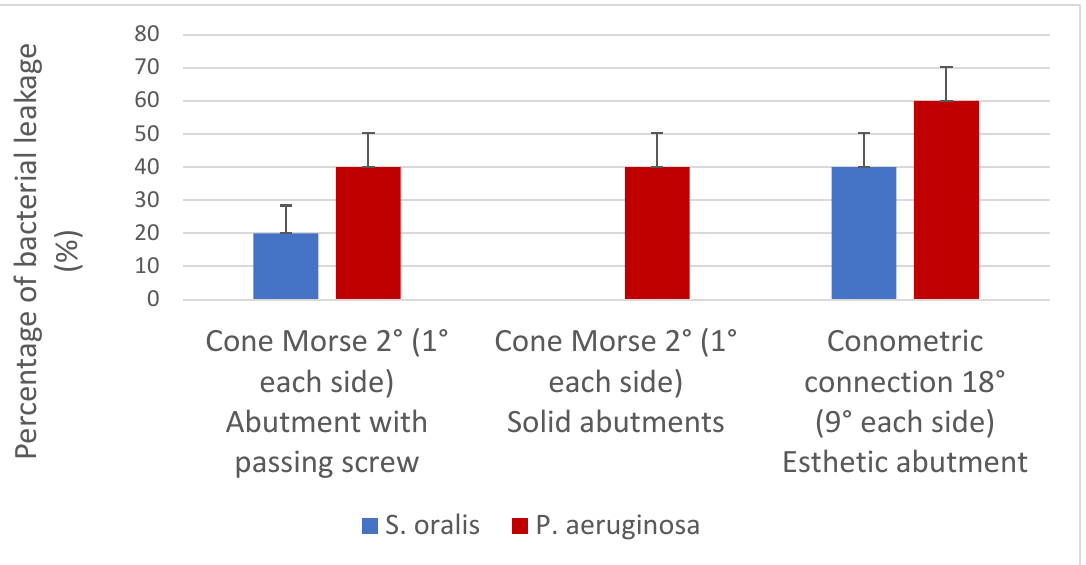
Figure 12. Percentage of bacterial leakage in the three different conometric connections over 90-day observation period (Error bars = standard deviation).